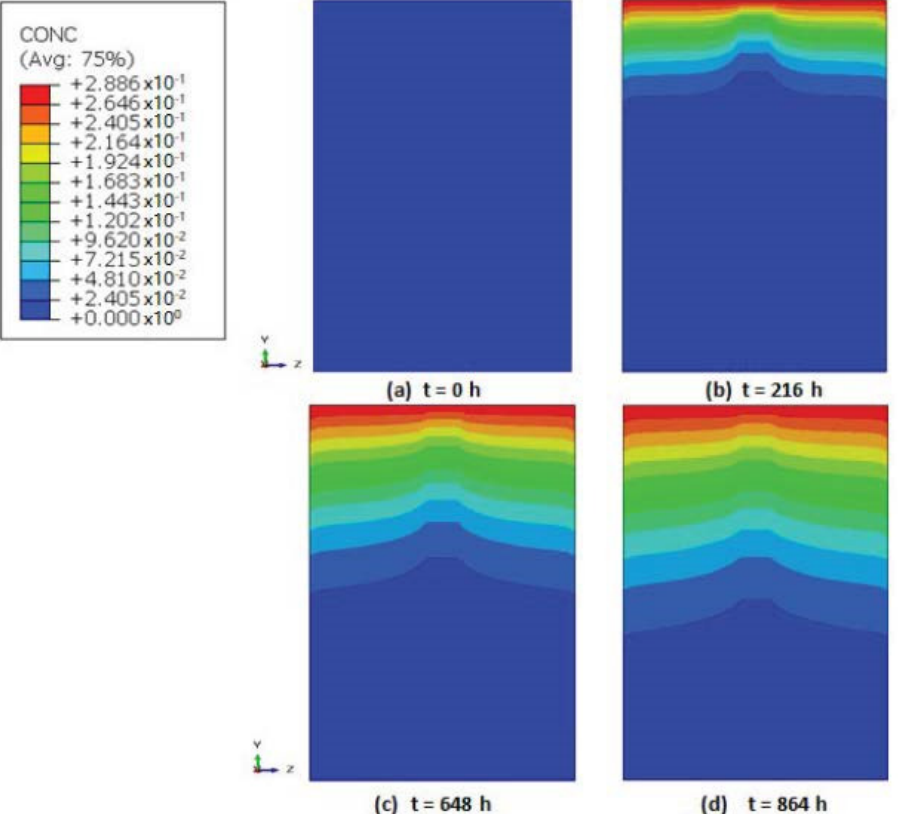
Figure 5. Illustration of numerical results at different aging times.